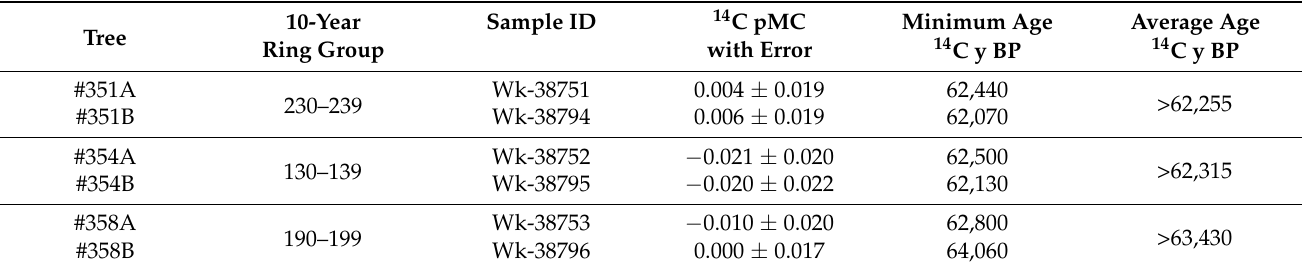
Table 2. Radiocarbon dating results from high-precision liquid scintillation counting at University of Waikato, NZ. Notice that the ages actually reflect the background levels achieved during